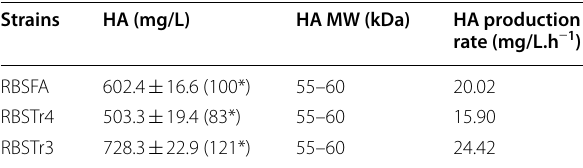
Table 3 HA titer, Mw and production rate of recombinant B. subtilis strains